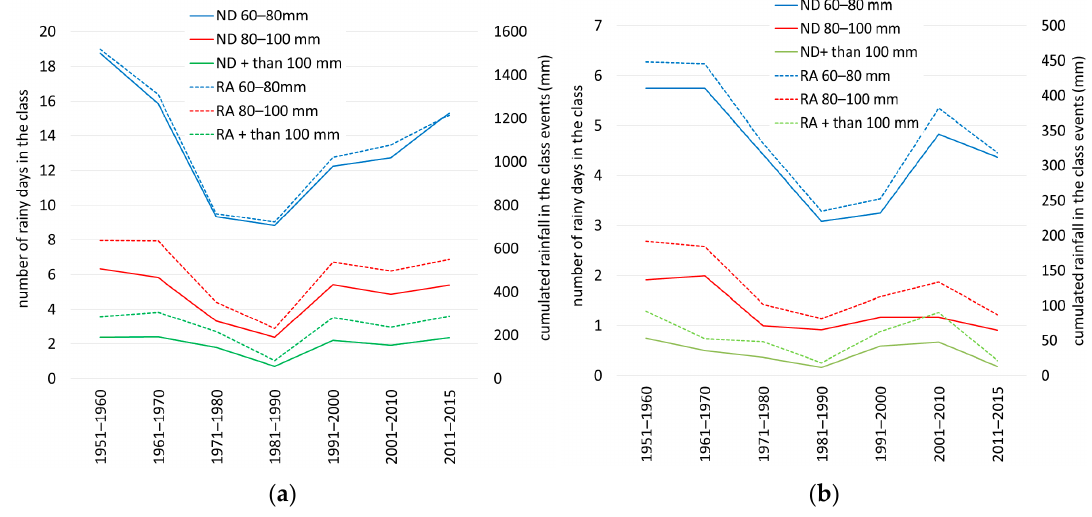
Figure 12. Decadal evolution of rainfall events above 60, 80 and 100 mm·day − 1 in Senegambia ( a ) and MNRB ( b ): number of rainy days (ND) and cumulated rainfall in each class (RA).